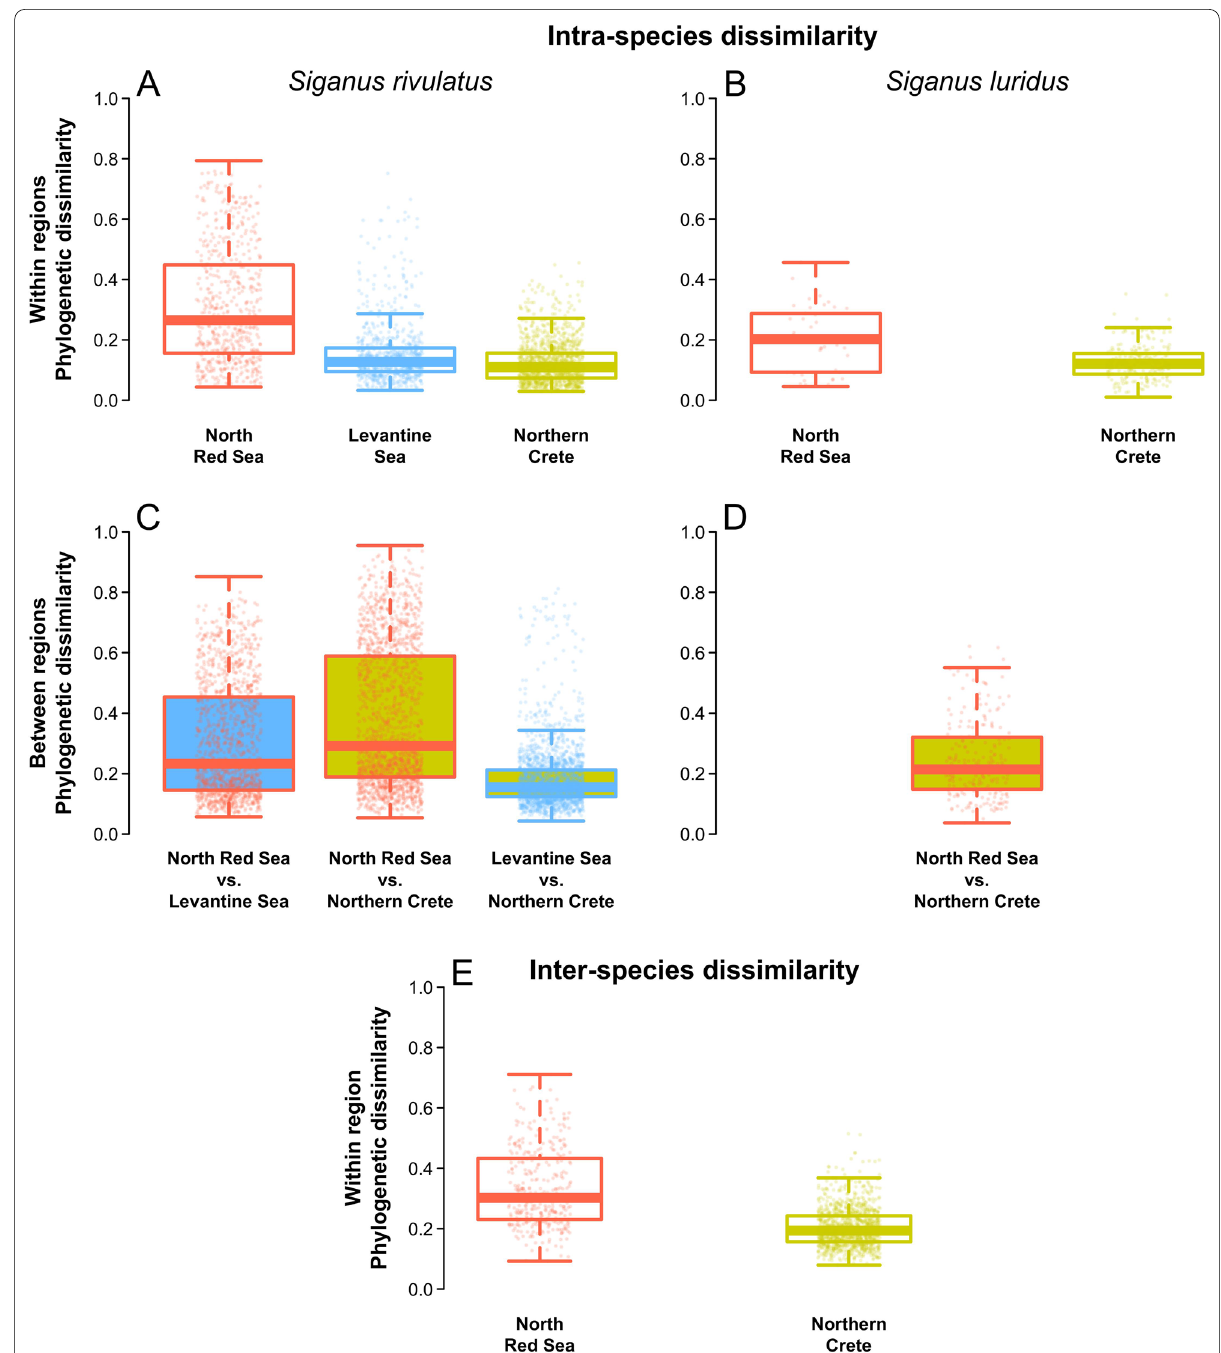
Fig. 4 Phylogenetic dissimilarity of the gut microbiome of Siganus across their native (Red Sea) and invaded range (Mediterranean Sea: Levantine Sea and Northern Crete). The top row represents intraspecific dissimilarity of the gut microbiome among S. rivulatus ( A ) or S. luridus ( B ) individuals, within each of the regions where samples were collected. The middle row represents intraspecific dissimilarity between S. rivulatus ( C ) or S. luridus ( D ) individuals, between the regions where they were sampled. The bottom row ( E ) represents interspecific dissimilarity between S. rivulatus ( A ) and S. luridus ( B ) individuals, in the two regions where they were sampled simultaneously. Phylogenetic dissimilarity was computed on relative abundance of